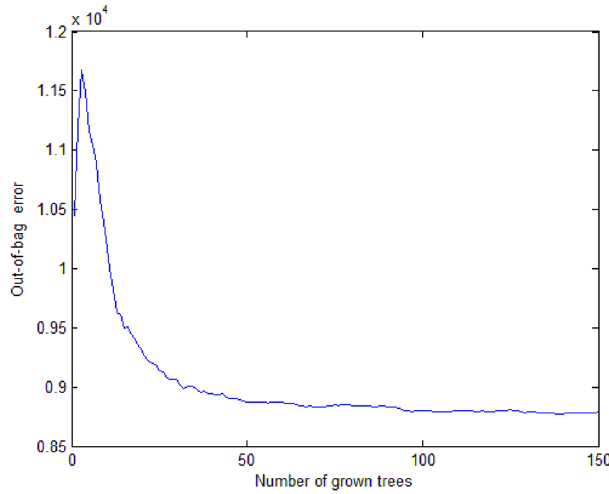
Figure 7. Out of bag error with different numbers of grown trees.